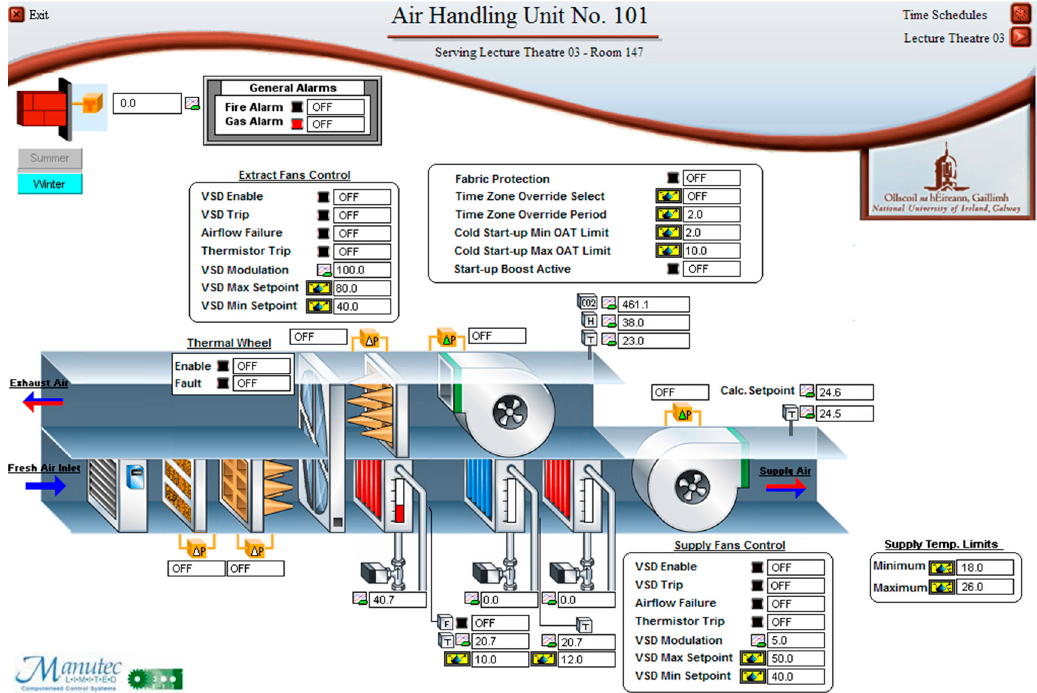
Figure 5. Air handling unit (AHU) system schema for lecture theatre representation in theBuilding Management System (BMS). BMS images are courtesy of Manutec. Ltd. Ballingarry, Co. Limerick, Ireland.